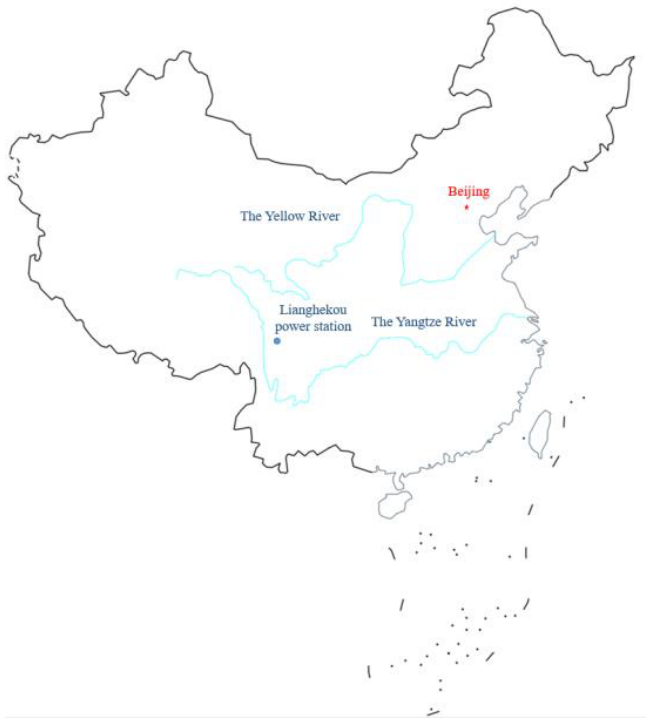
Figure 18. Location of the Lianghekou power station.